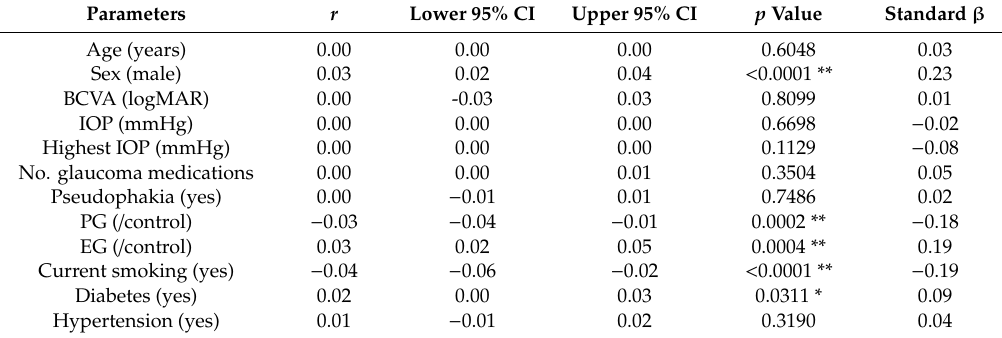
Table 5. Possible associations among advanced glycation end products and various parameters analyzed by a multiple regression